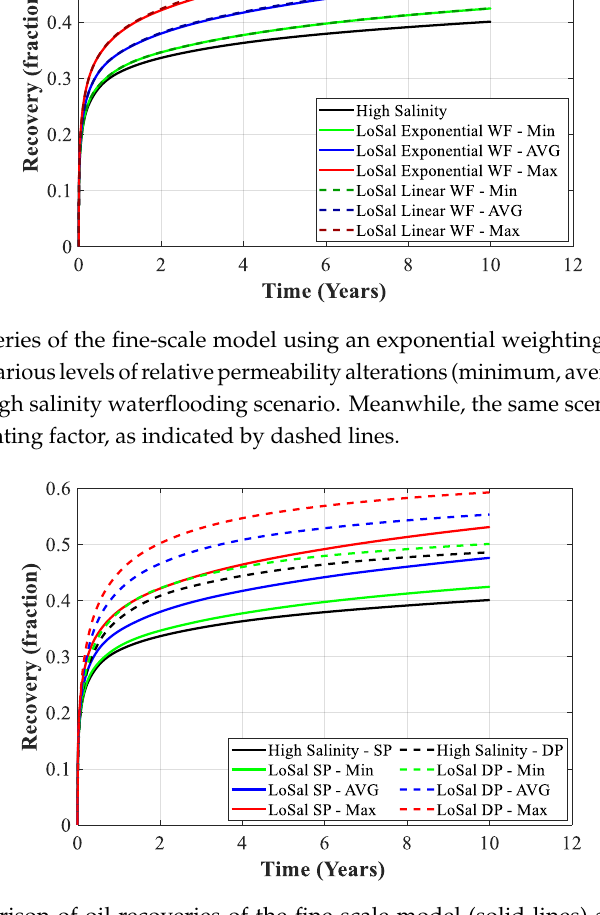
Figure 9. A comparison of oil recoveries of the fine-scale model (solid lines) and the single block model (dashed lines) using an exponential weighting factor for various levels of relative permeability alterations (minimum, average, and maximum), in addition to high salinity waterflooding scenario. Table 3. Simulation results of fine-scale and single block models using single and dual-porosity models, respectively, highlighting the recovery differences between their performance.